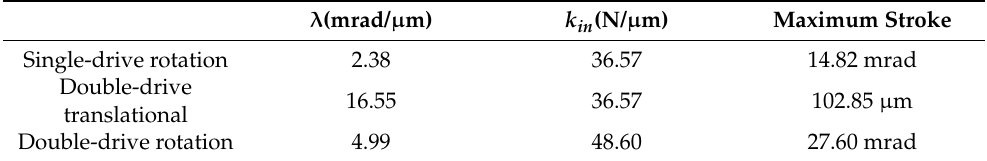
Table 4. Theoretical calculation